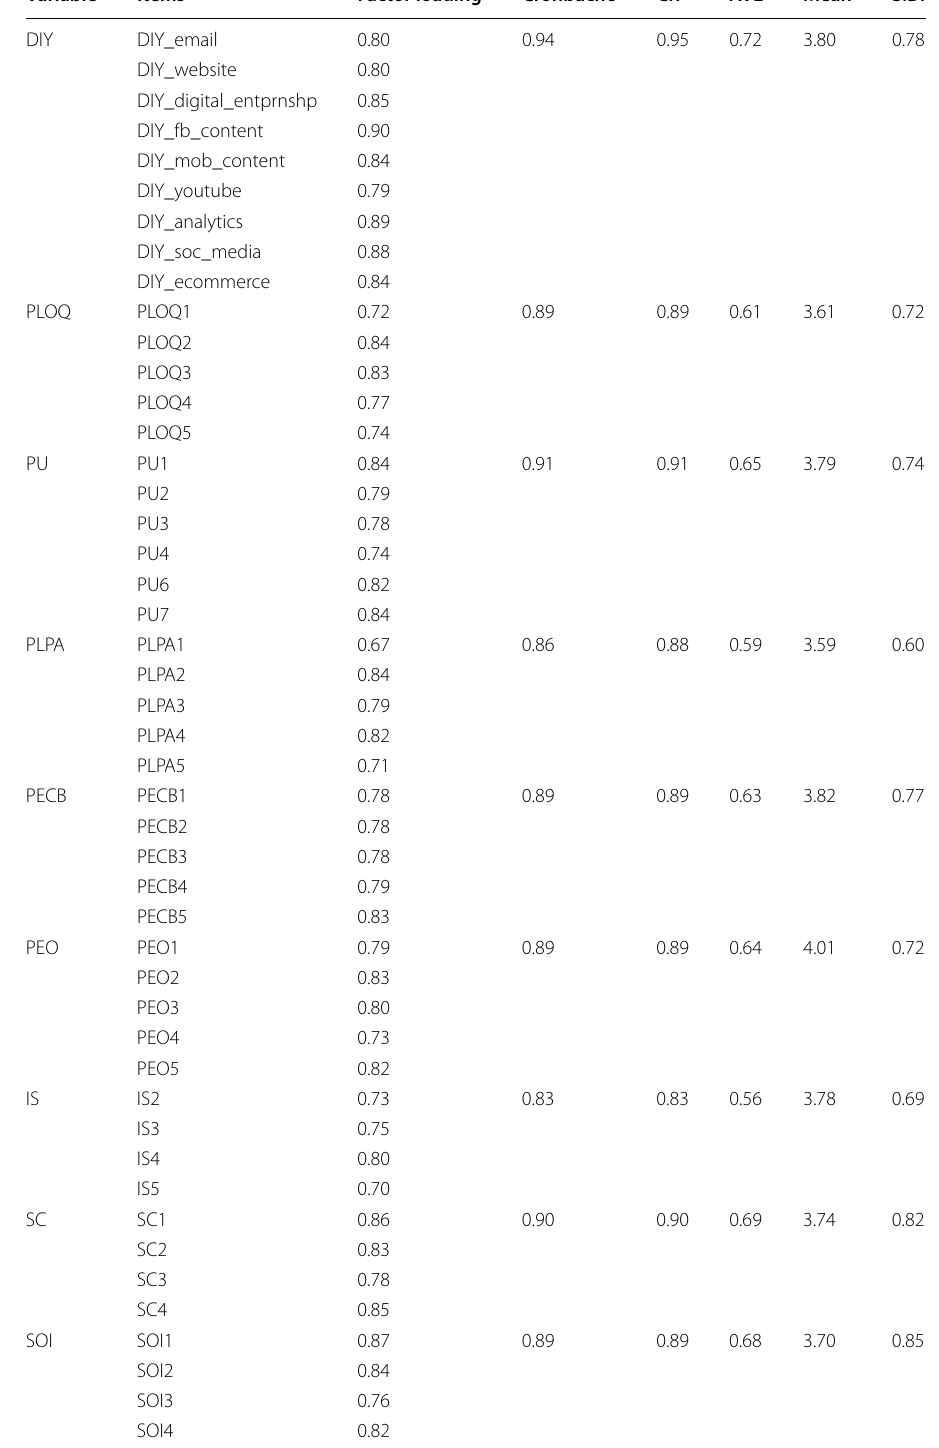
Table 2 Statistics of construct